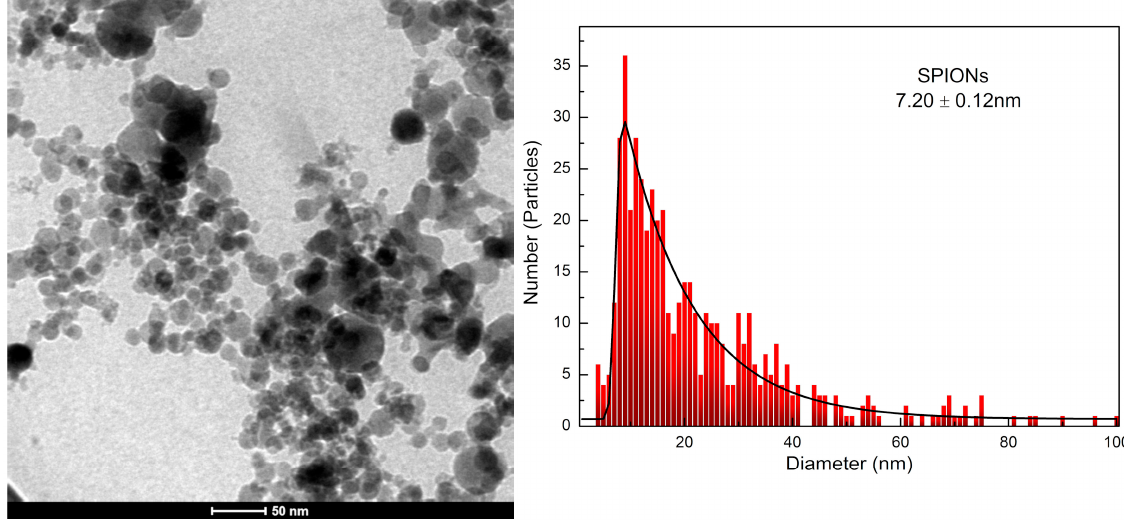
Figure 2. TEM micrograph of SPIONs and size histogram.